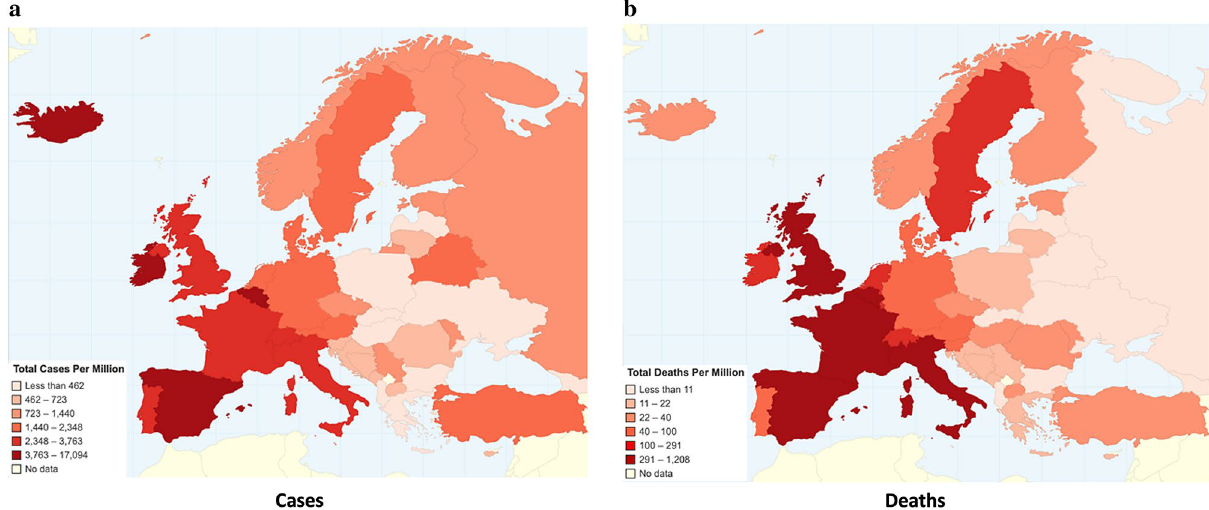
Figure 2. Total COVID-19 ( a ) cases and ( b ) deaths per million population in Europe (Chartsbin 22